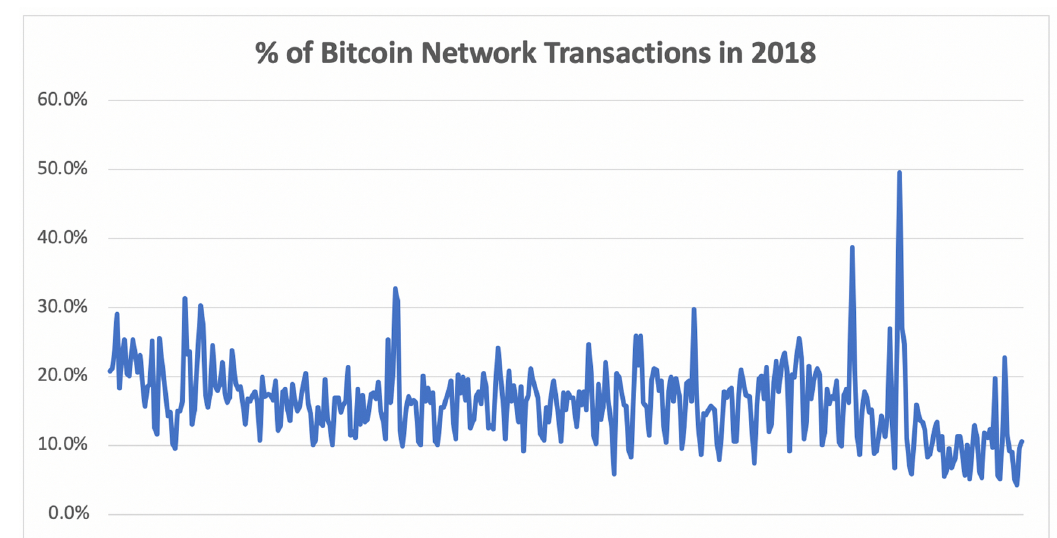
Figure 4: Data Money Markets undermining of Blockchains